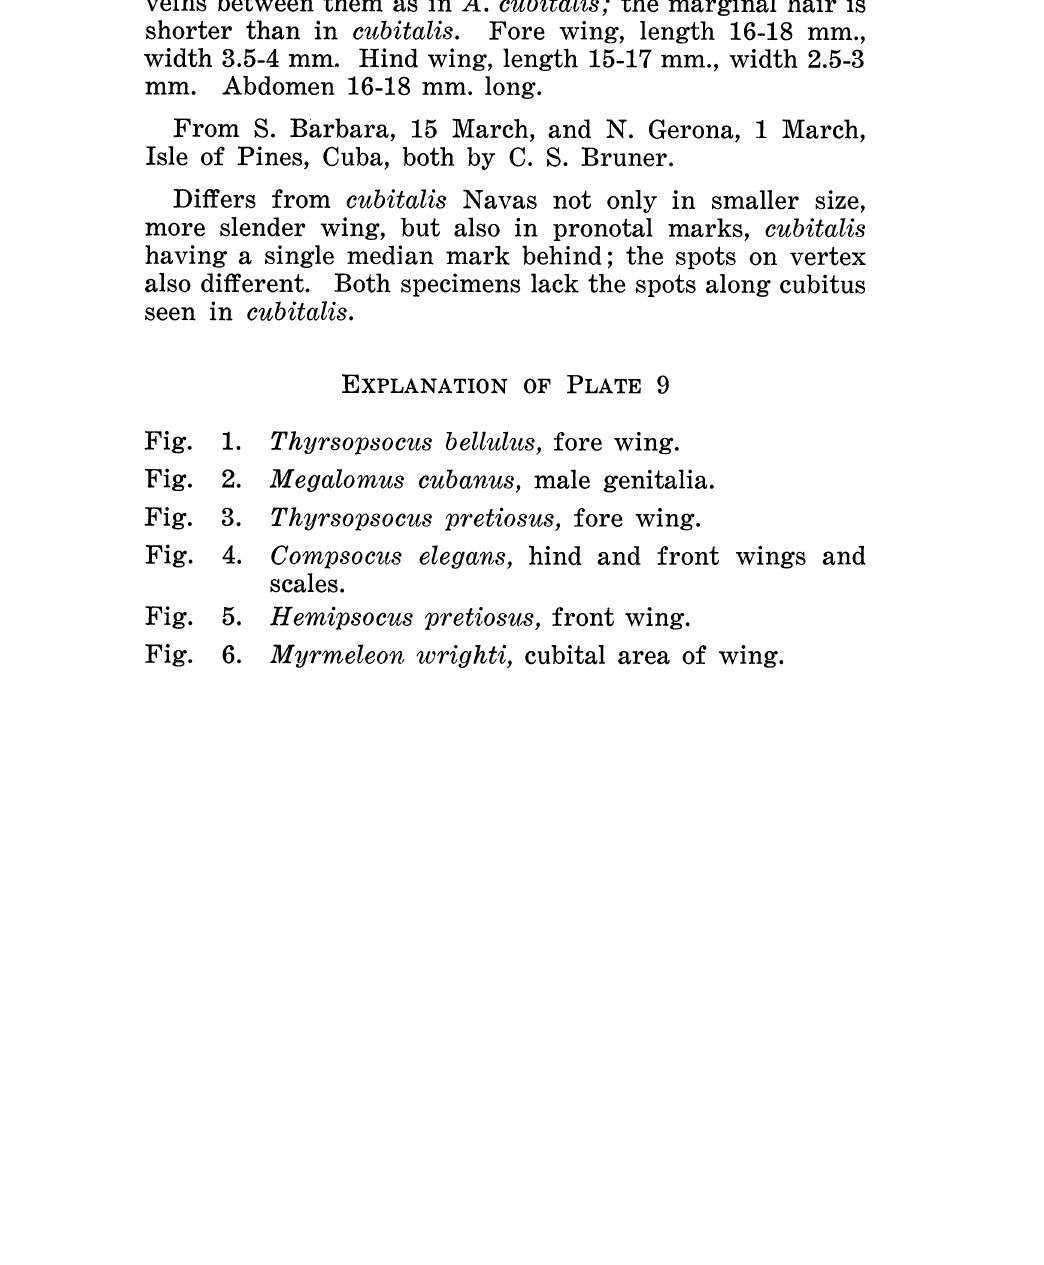
Fig. 1. Thyrsopsocus bellulus, ore wing. Fig. 2. Megalomus cubanus, male genitalia. Fig. 3. Thyrsopsocus pretiosus, fore wing. Fig. 4. Compsocus elegans, hind and front wings and scales. Fig. 5. Hemipsocus pretiosus, ront wing. Fig. 6. Myrmeleon wrighti, cubital area of